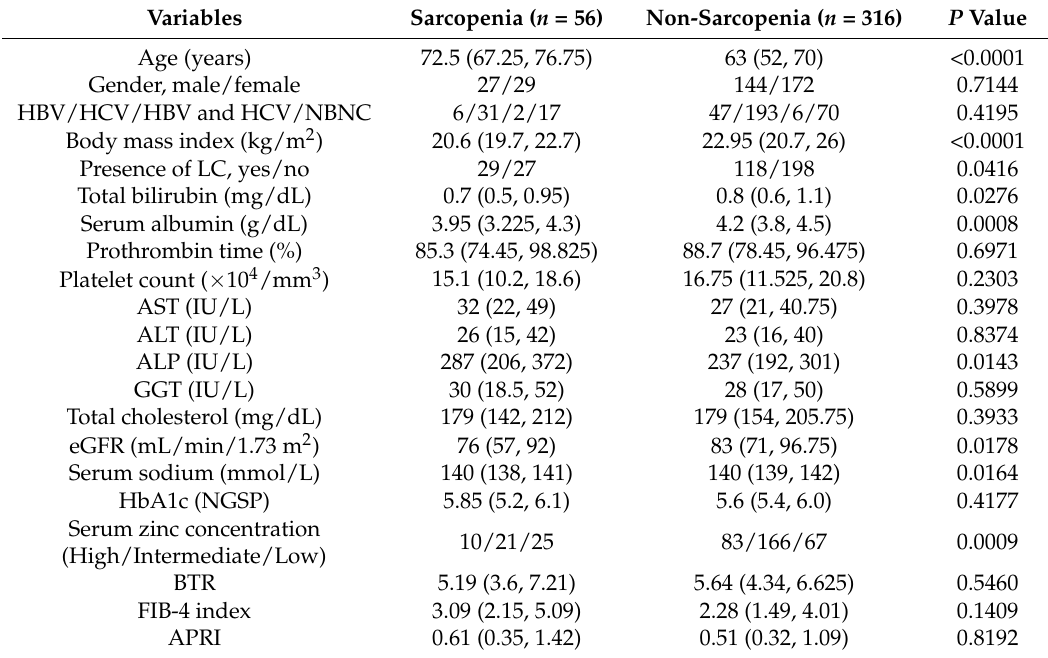
Table 2. Univariate analyses of factors associated with the presence of sarcopenia for all cases ( n = 372). Variables